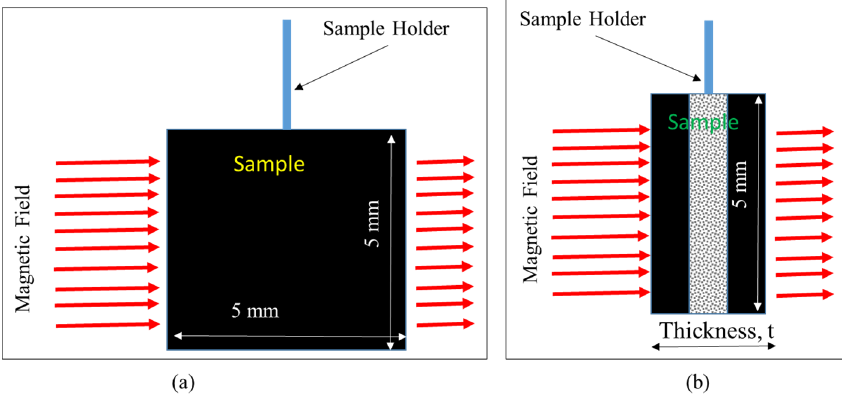
Figure 3. Placement of specimen with respect to magnetic field direction during the VSM measurement: ( a ) field applied parallel to the specimen (in-plane fields); ( b ) field applied perpendicular to the specimen (through-thickness fields).